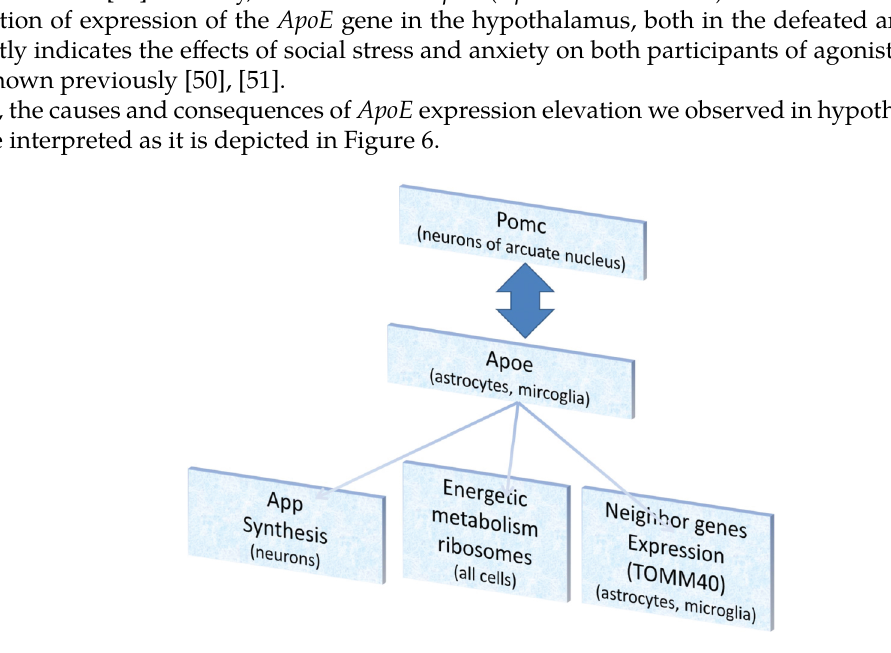
Figure 6: Schematic diagram of APOE mediated pathways elucidated from RNA-Seq data in current study. The major cause of ApoE elevation in the hypothalamus can be the neuroendocrine stress response, which induces Pomc expression and adrenocorticotropic hormone in particular [52]. We observed high Pomc elevation in stressed mice compared to mice in the control group (Supplementary Table 1; p < 2E − 5 for stress groups